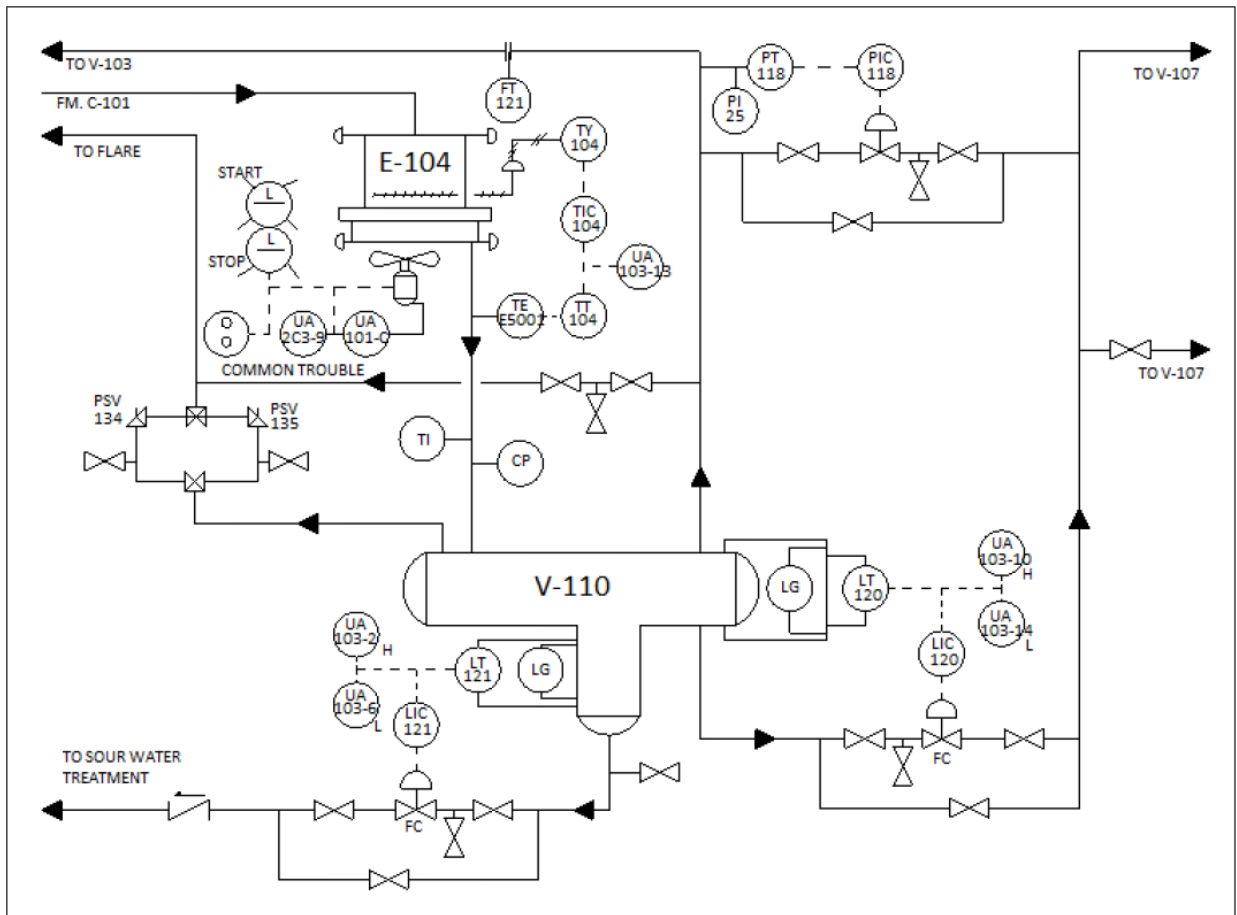
Figure 4. Node#7 shows the gas-compressor cooling system and liquid recovery device .